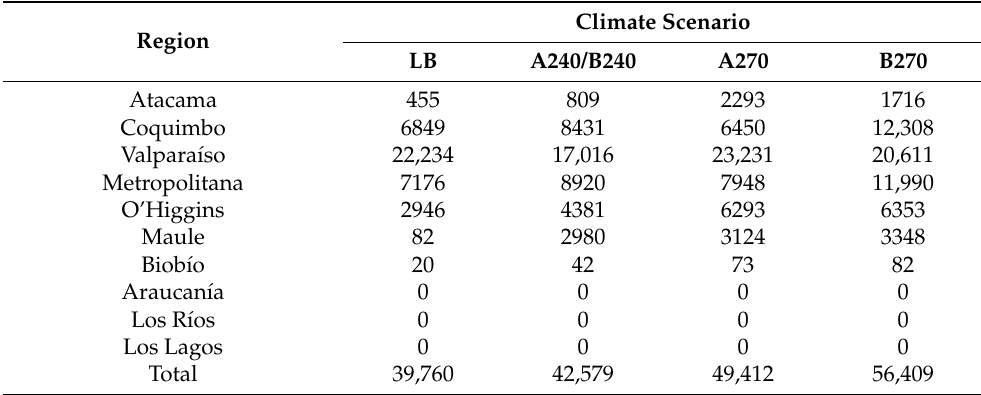
Climate Scenario